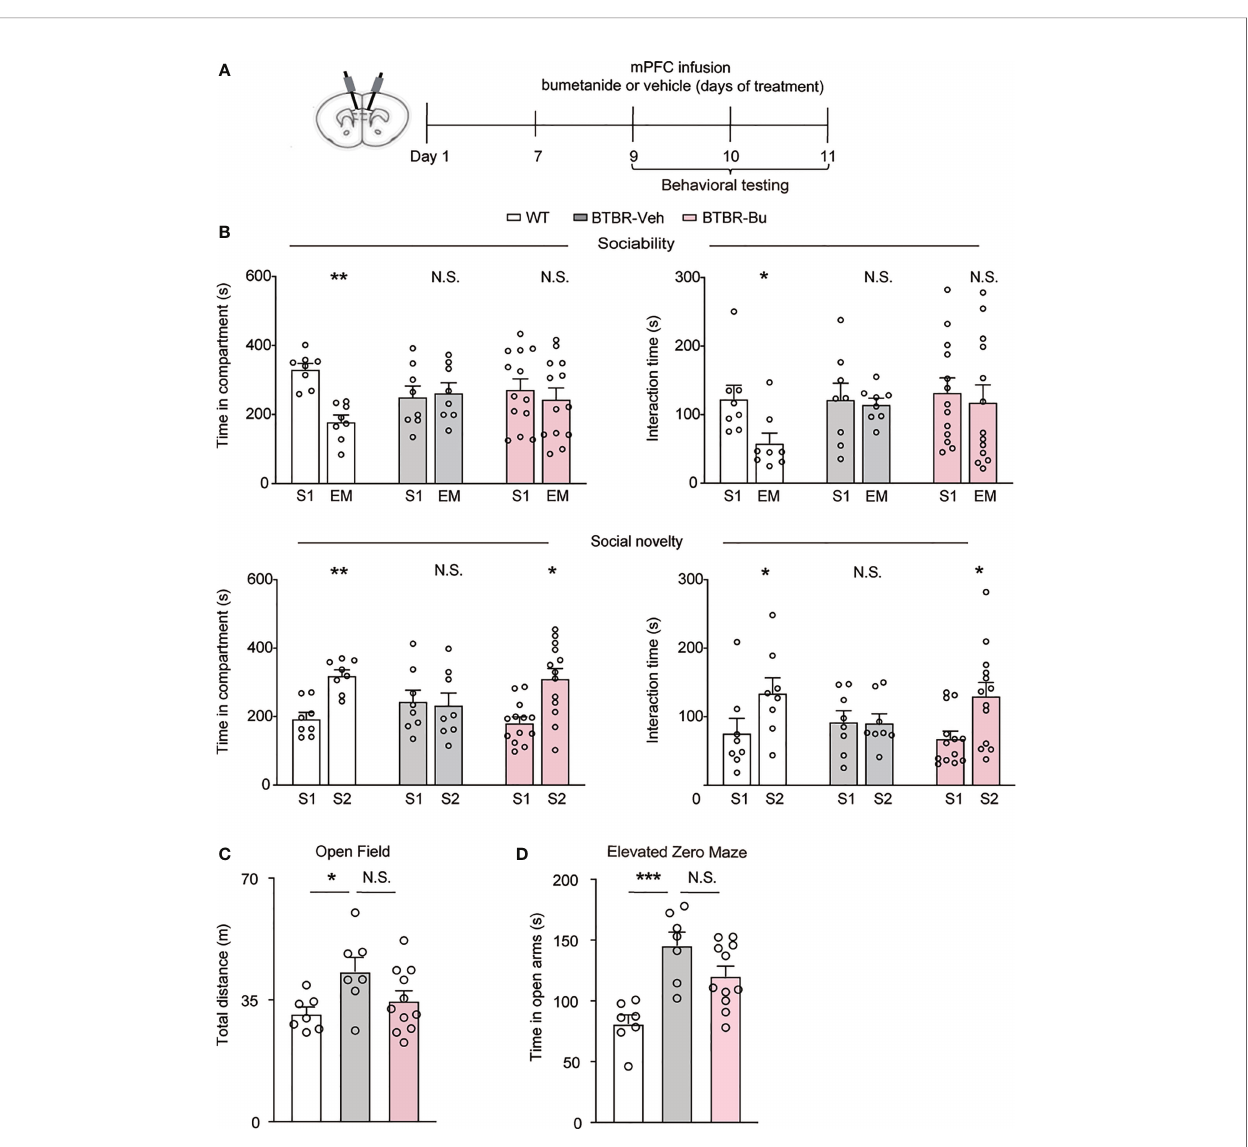
FIGURE 2 | mPFC region-speci fi c infusion with bumetanide alleviated social de fi cit in BTBR mice. (A) Schematic representation of the experimental procedure. Male BTBR mice were administrated with bumetanide (100 m M) or vehicle into mPFC. (B) Top: time spent in the social stimulus or empty chamber and total interaction time with stimulus mouse or empty wire during sociability stage (WT, n = 8; BTBR-vehicle, n = 8; BTBR-bumetanide, n = 13. paired Student ’ s t -test. Time in compartments, ** p < 0.01, WT S1 vs. EM; N.S., not signi fi cant, BTBR-vehicle S1 vs. EM; N.S., not signi fi cant, BTBR-bumetanide S1 vs. EM; interaction time, * p < 0.05, WT S1 vs. EM; N.S., not signi fi cant, BTBR-vehicle S1 vs. EM; N.S., not signi fi cant, BTBR-bumetanide S1 vs. EM). Bottom: time spent in familiar or novel stimulus chamber and total interaction time with familiar or novel stimulus mouse during social novelty stage (paired Student ’ s t -test. Time in compartments, ** p < 0.01, WT S1 vs. S2; N.S., not signi fi cant, BTBR-vehicle S1 vs. S2; * p < 0.05, BTBR-bumetanide S1 vs. S2; interaction time, * p < 0.05, WT S1 vs. S2; N.S., not signi fi cant, BTBR-vehicle S1 vs. S2; * p < 0.05, BTBR-bumetanide S1 vs. S2). (C) Total distance traveled in the open fi eld test (WT, n = 7; BTBR-vehicle, n = 7; BT BR-bumetanide, n = 11, one-way ANOVA, F (2,22) = 3.651, p = 0.0427, Bonferroni post hoc : * p < 0.05, WT vs. BTBR-vehicle; N.S., not signi fi cant, BTBR-vehicle vs. BTBR-bumetanide). (D) Time spent in the open arm during 5 min in elevated zero maze test (WT, n = 7; BTBR-vehicle, n = 7; BTBR-bumetanide, n = 11, one-way ANOVA, F (2,22) = 11.74, p =0.0003, Bonferroni post hoc : *** p <0.001, WT vs. BTBR-vehicle; N.S., not signi fi cant, BTBR-vehicle vs. BTBR-bumetanide). Data were presented as mean ±